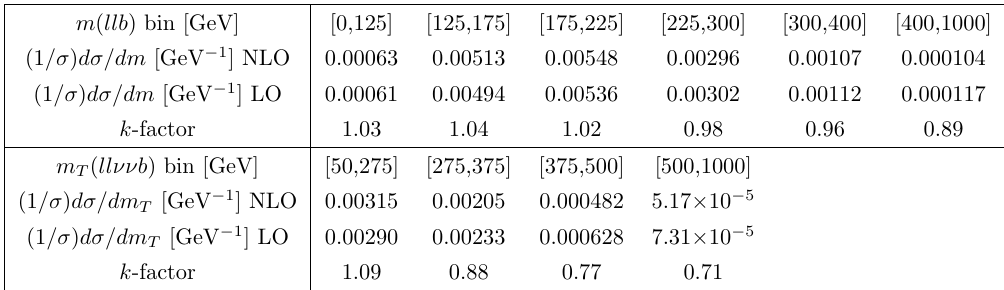
Table 2 . k -factors for m ( llb ) and m T ( ll(cid:23)(cid:23)b ) that we estimate by comparing the distributions of NLO with tree-level SM events generated with MadGraph5 aMC@NLO and showered with PYTHIA8 . applying the diagram removal procedure [80] where one removes all diagrams in the NLO real emission amplitudes that are doubly t